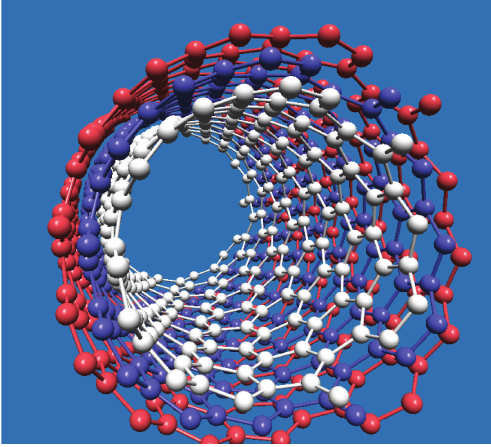
Figure 6: Schematic representation of a Multi wall carbon nan- otube (MWNT).